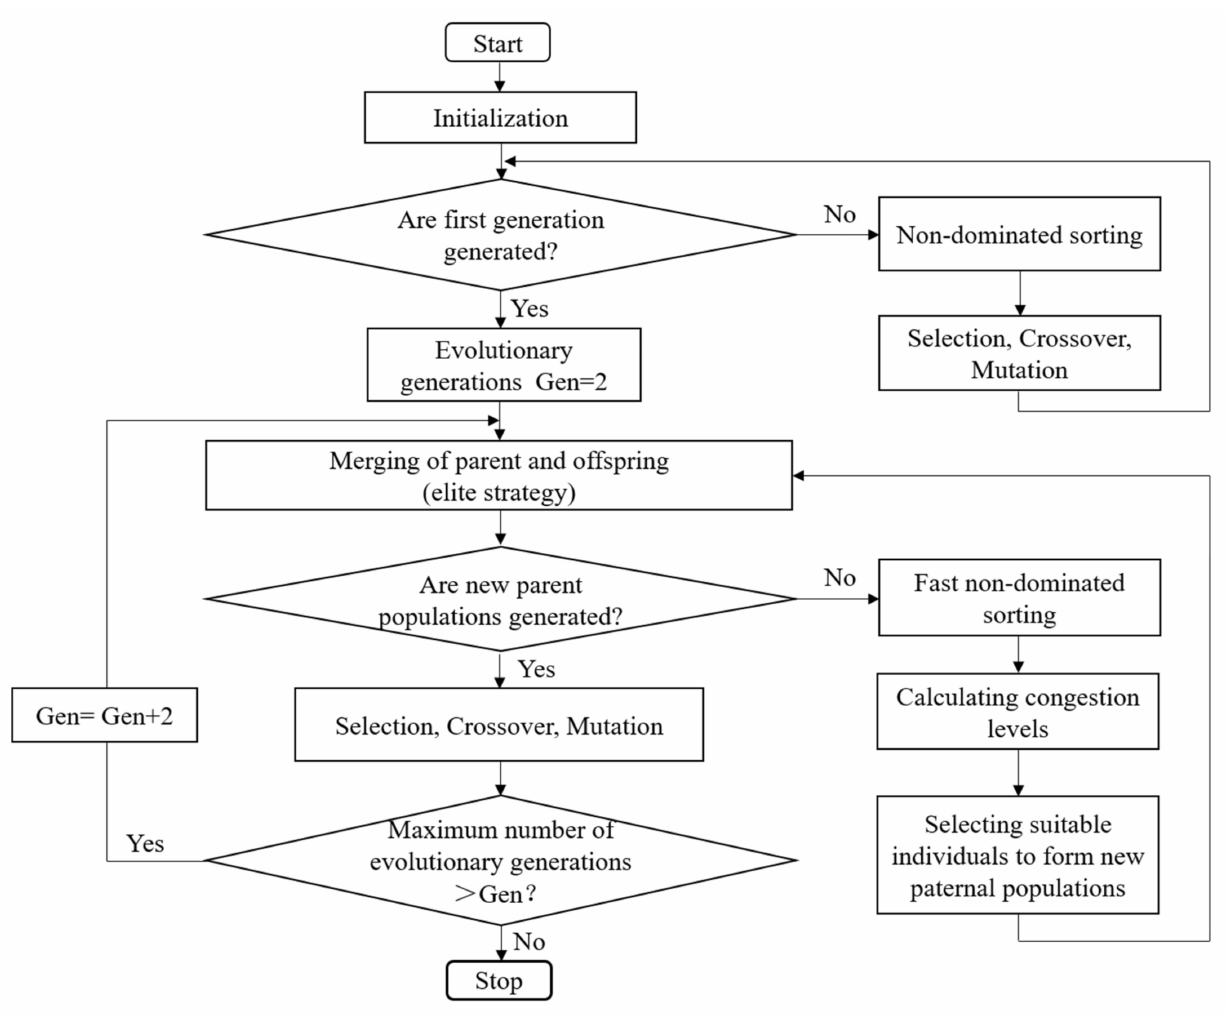
Figure 1. Flow chart of NSGA-II